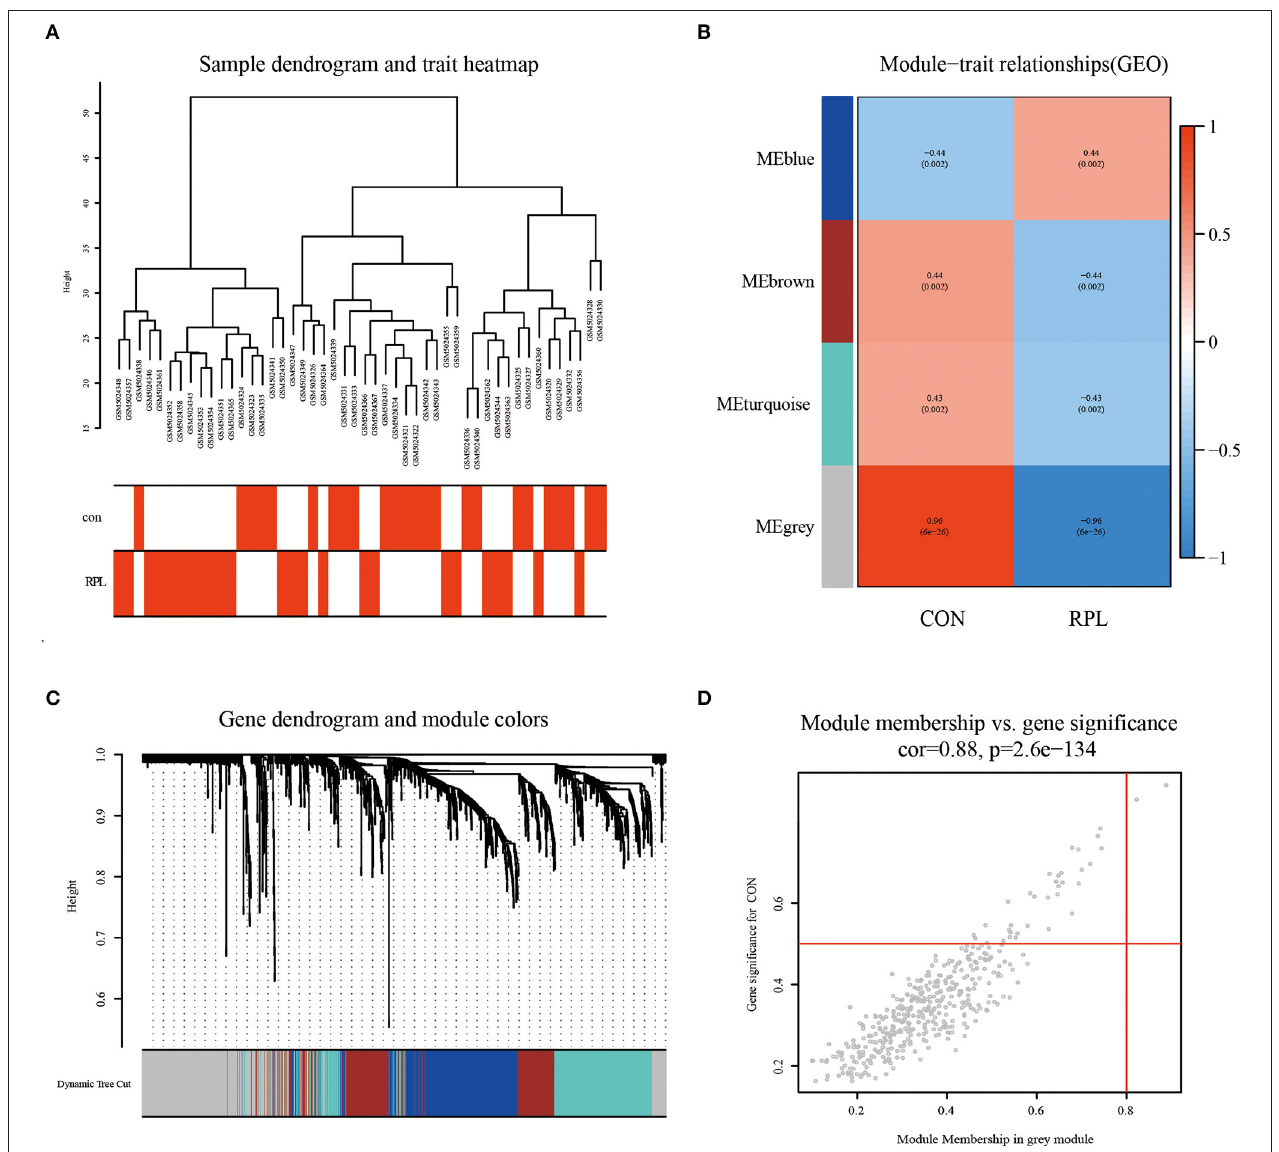
FIGURE 3 | The results of WGCNA on the RPL dataset (GSE165004). (A) Dendrograms and corresponding feature heatmaps of the healthy and RPL samples. (B) Heatmap of correlations between gene modules and clinical features. (C) Cluster dendrogram of co-expressed genes in EMs. (D) Correlation analysis results of gray gene modules and